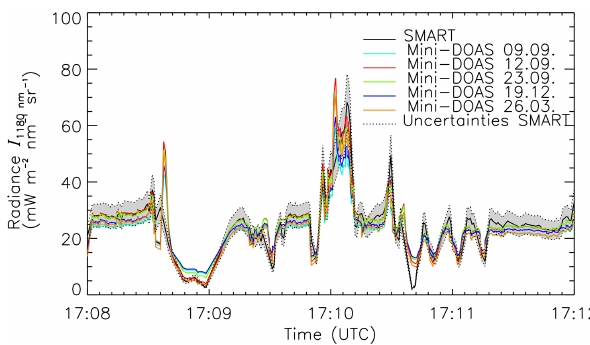
Figure 10. Time series of the nadir radiance of SMART I N S , 1180 and of the mini-DOAS I N nadir channel at λ = 1180nm us- mD , 1180 ing different calibrations as indicated in the legend. The uncertainty range of SMART radiance is shaded